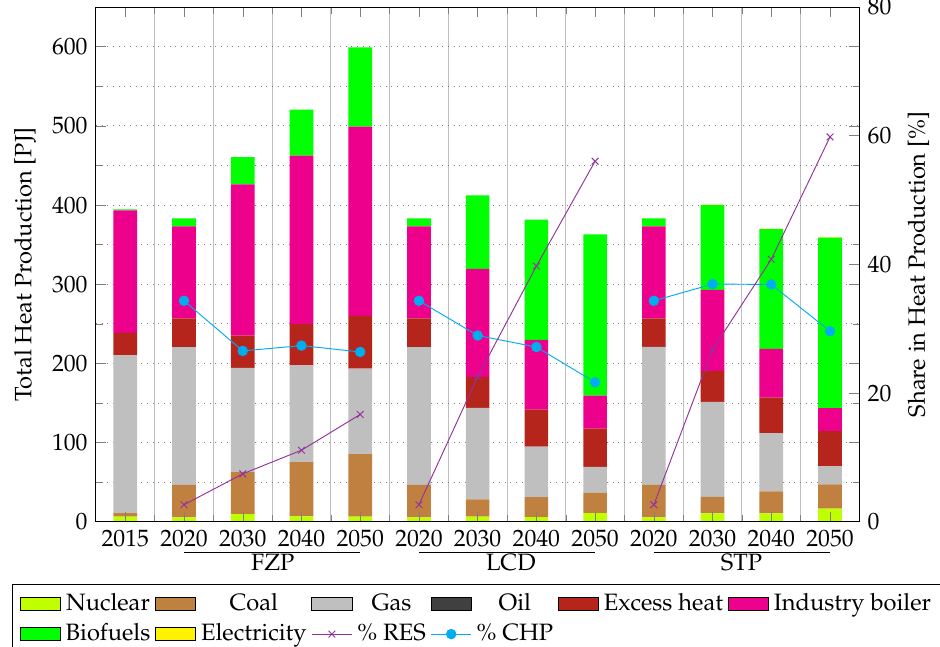
Figure 3. Total heat production by fuel type for three main scenarios.